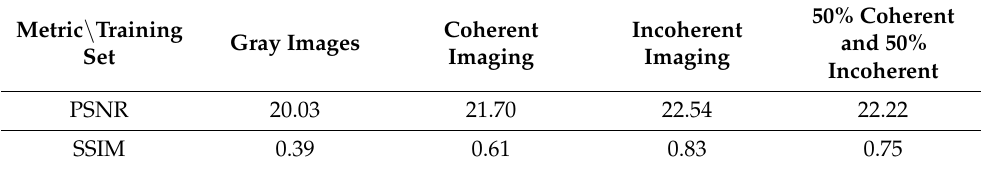
Table 4. The metrics between different training sets and the real dataset. Metric \ Training